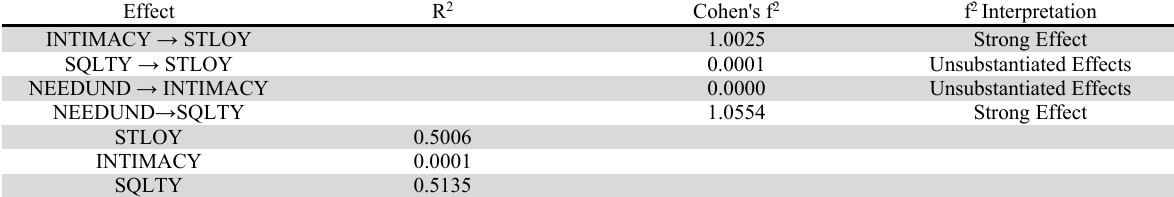
Report of R-Squared statistic and Cohen’s Effect size